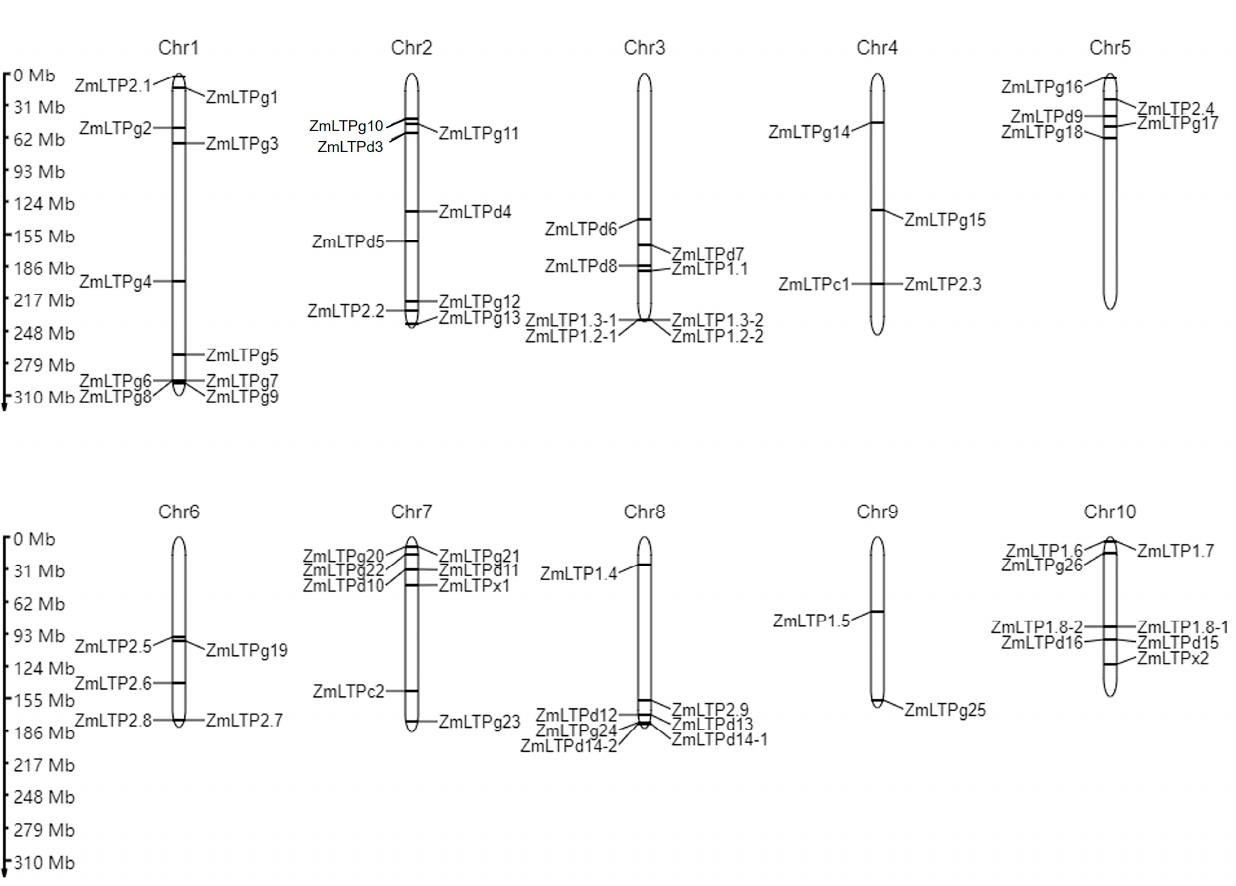
Figure 1. Genomic distribution of the 65 ZmLTP genes in maize chromosomes. Chromosome numbers are indicated at the top of each chromosome, respectively. The physical location of each ZmLTP gene is indicated to the right of chromosomes. Mb, million base pair.